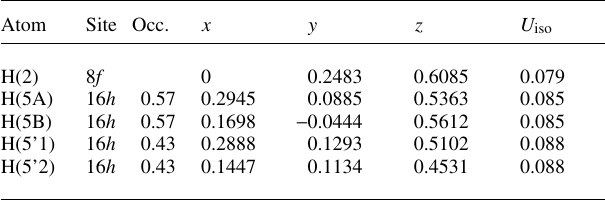
Table 2. Atomic coordinates and displacement parameters (in Å 2 ) .